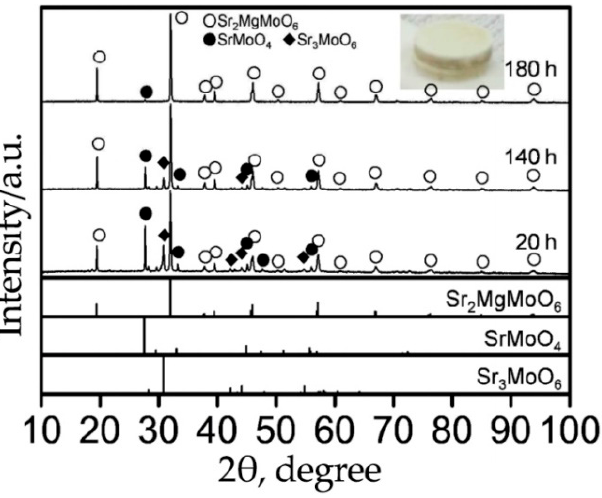
Figure 8. XRD patterns recorded for Sr 2 MgMoO 6– δ calcined in air at different exposure times. Reproduced with permission [98]. Copyright 2017, John Wiley & Sons.